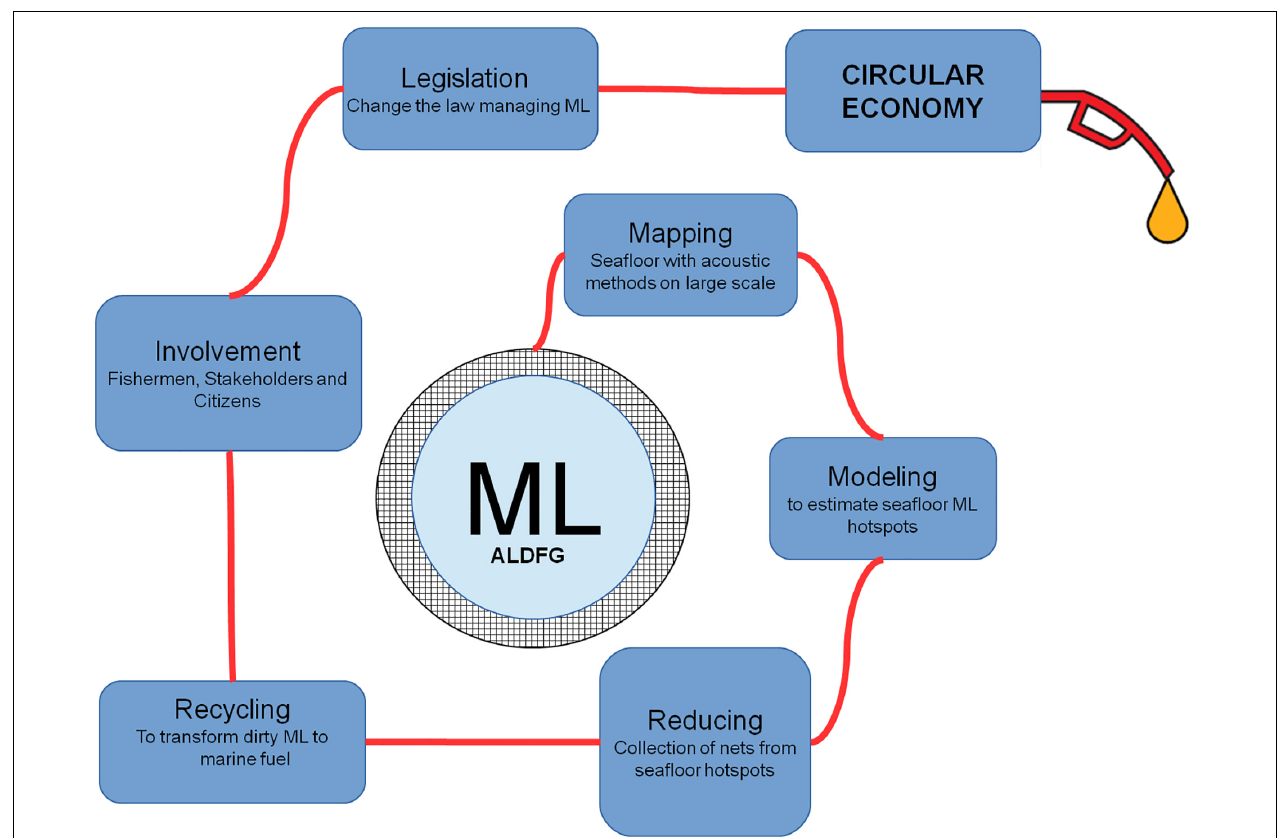
FIGURE 1 | Conceptual model illustrating the main actions needed to tackle the marine litter